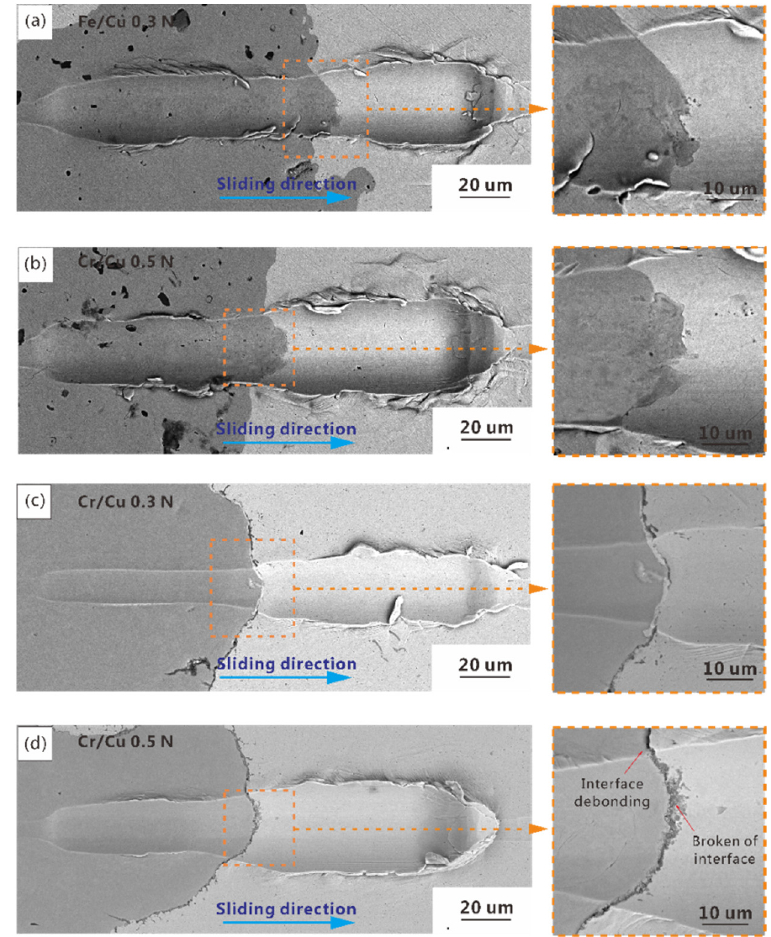
Figure 8. Scratch grooves of the Fe/Cu interface and Cr/Cu interface with different forces: ( a ) 0.3 N Fe/Cu interface; ( b ) 0.5 N Fe/Cu interface; ( c ) 0.3 N Cr/Cu interface; and ( d ) 0.5 N Cr/Cu interface.